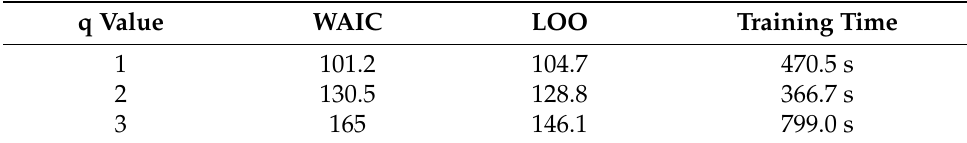
Table 2. Performance comparison of different q value.